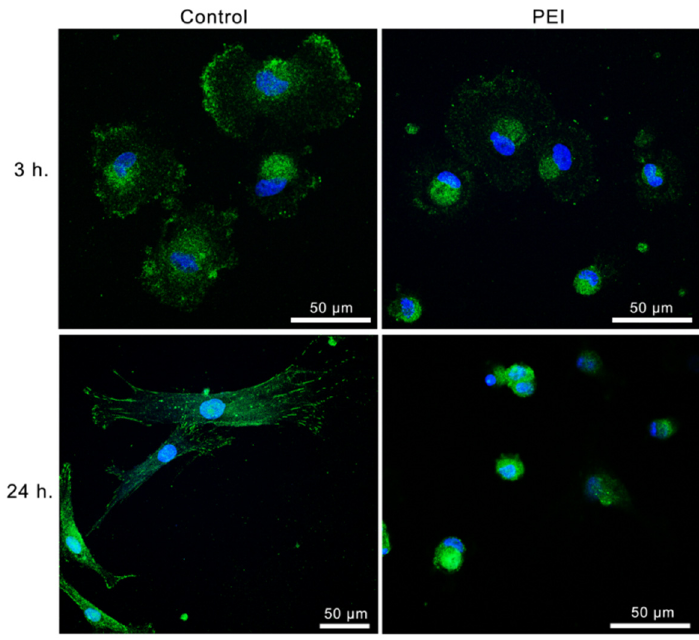
Figure 6. Representative images of MSCs after 3 h and 24 h of culture time on glass slides and PEI-ended slides. Green represents FITC-conjugated antibody stain of FAK, blue represents DAPI stain of nuclei. Scale bars: 50 μ m.